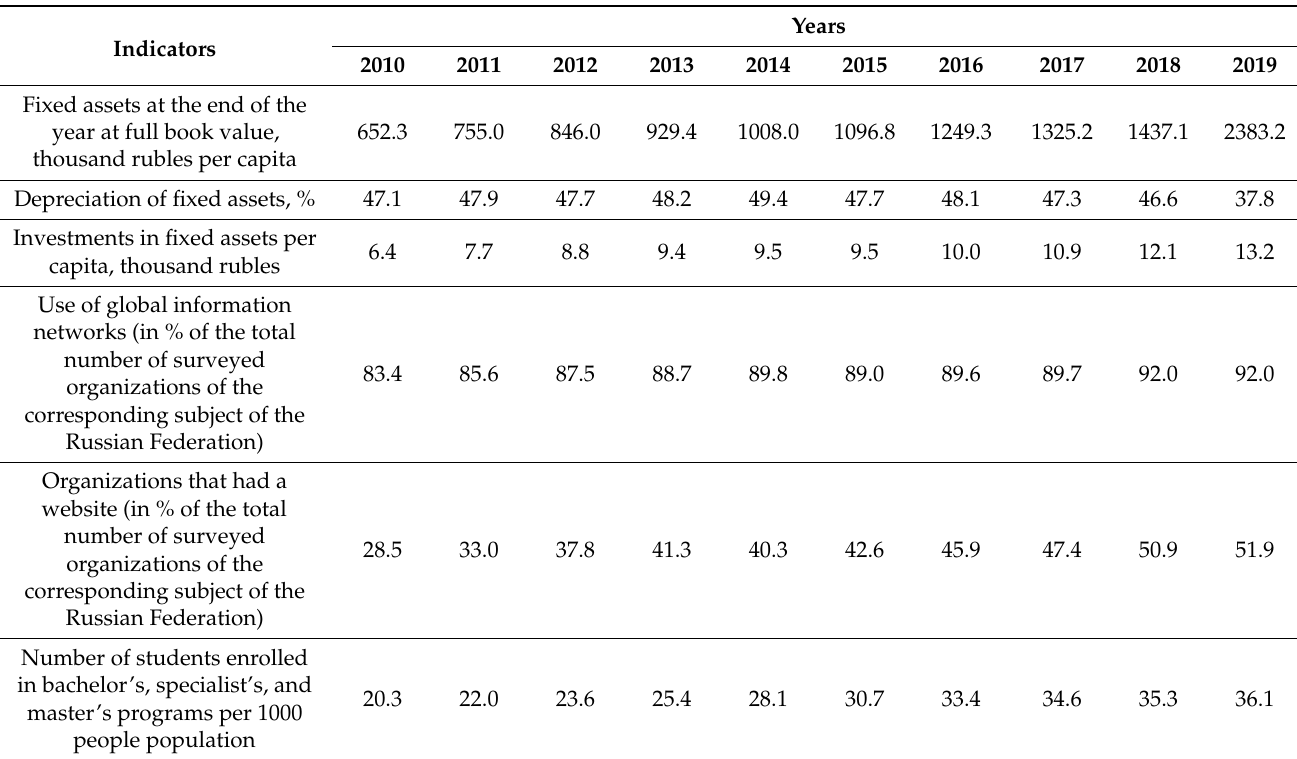
Table 11. Main indicators characterizing the macro-regional block “Prospects” in the Russian Federa- tion in